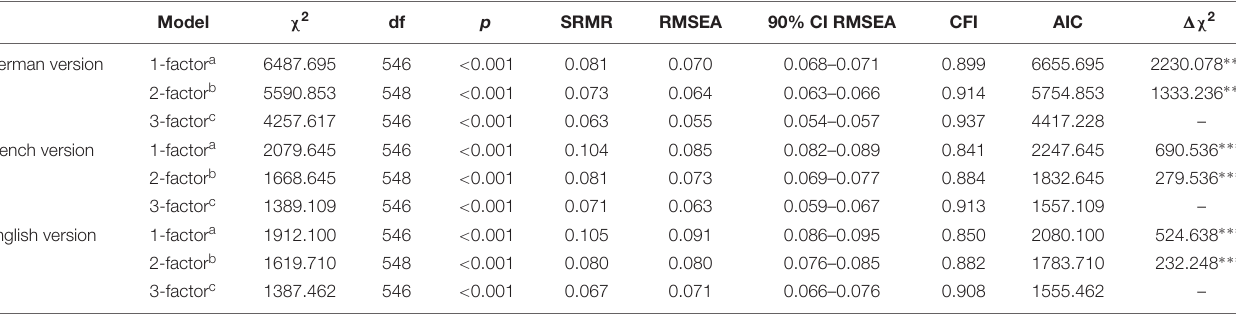
TABLE 4 | Confirmatory factor